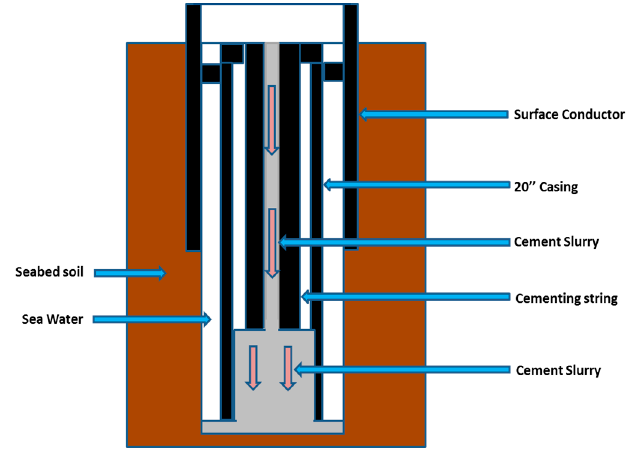
Figure 7. Landed load analysis during the cementing operation of 20 ″ casing.